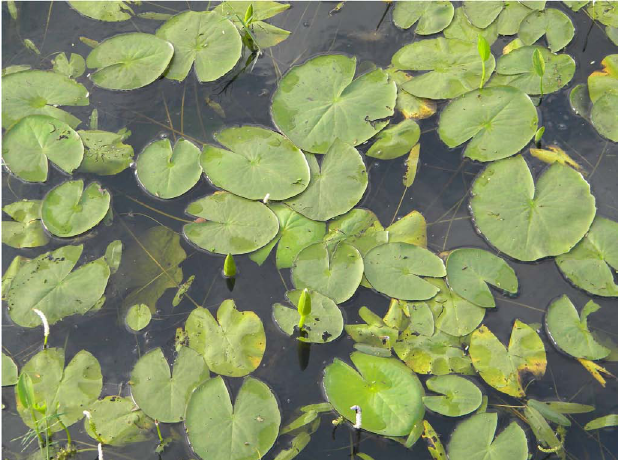
Figure 8. Polygonum glabrum the lake.